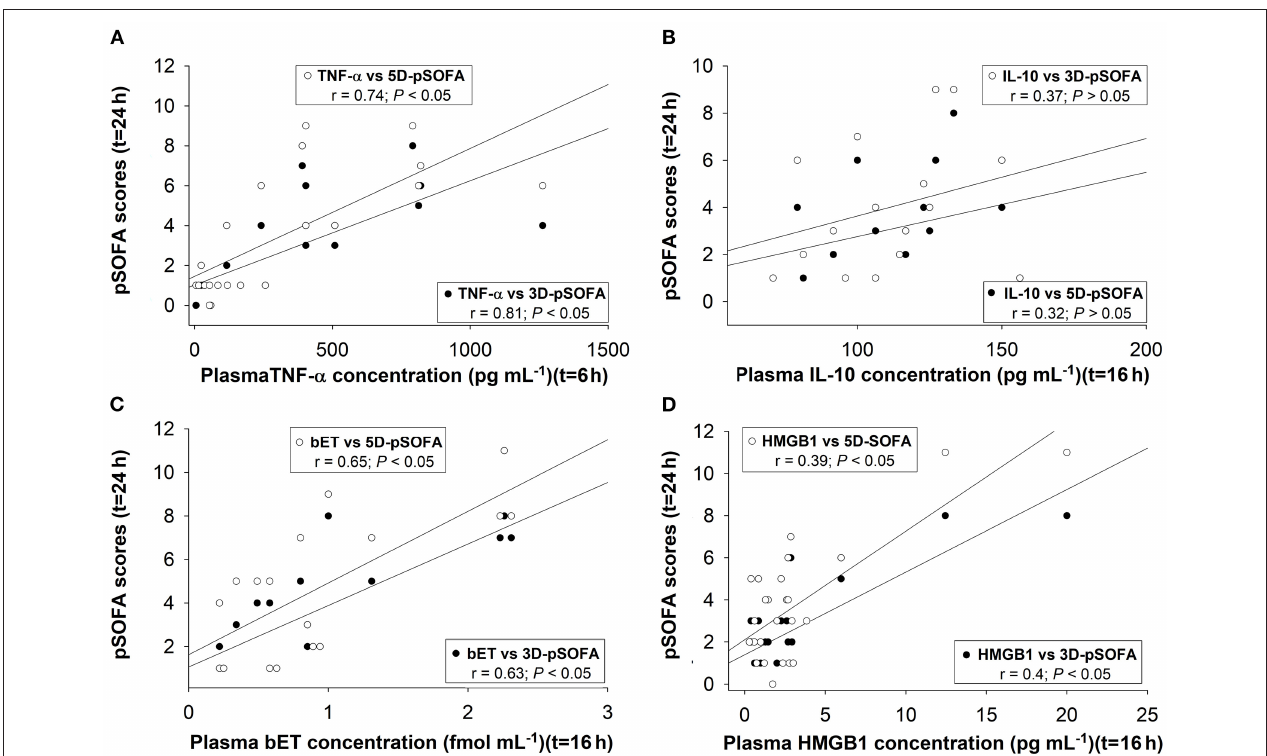
FIGURE 9 | Correlations between plasma concentrations of TNF- α at 6t = h (A) , interleukin-10 (IL-10) (B) , big endothelin (bET) (C) , high-mobility group box 1 protein (HMGB1) at t = 16h (D) , and 3D-pSOFA and 5D-pSOFA scores at t = 24h.